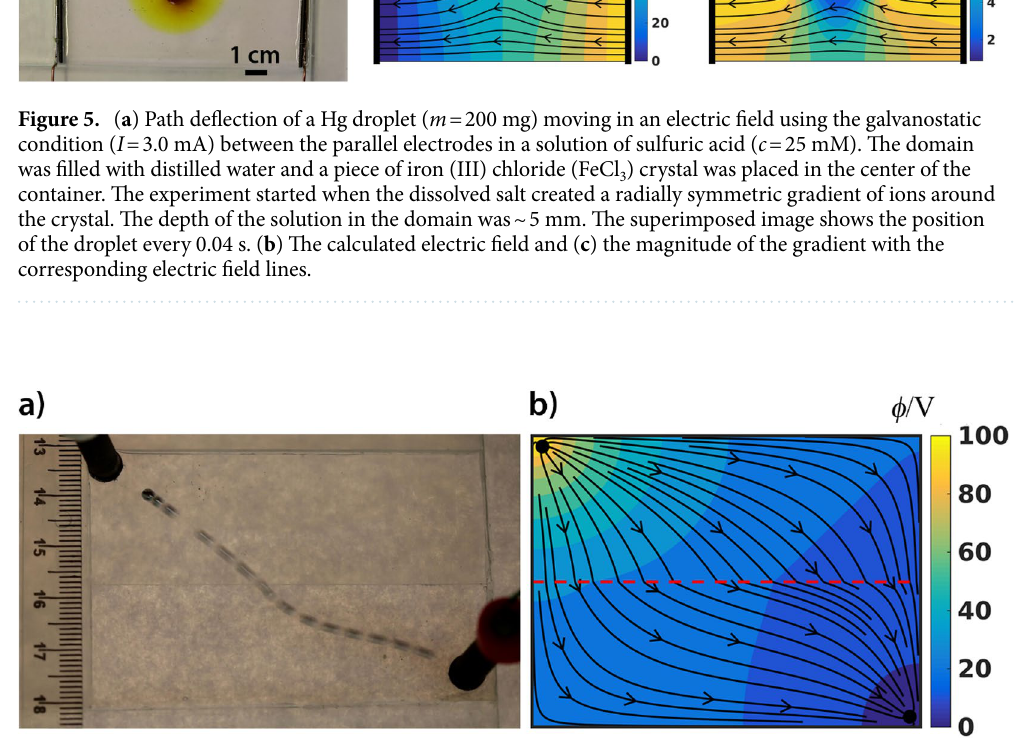
Figure 6. Refraction of the path of a Hg droplet ( m = 80 mg) moving in an electric field through a boundary separating two different conductivity regions using the galvanostatic condition ( I = 25 mA). The domain was filled with a solution of sulfuric acid ( c = 25 mM). The depths of the solution were 2 mm (upper part) and 3 mm (bottom part). The superimposed image shows the position of the droplet every 0.04 s. The droplet in the lower conductive (higher resistance and current density) region moved faster than in the higher conductive (lower resistance and current density) region ( b ) The calculated electric field in the domain having two different conductive parts with the corresponding electric field